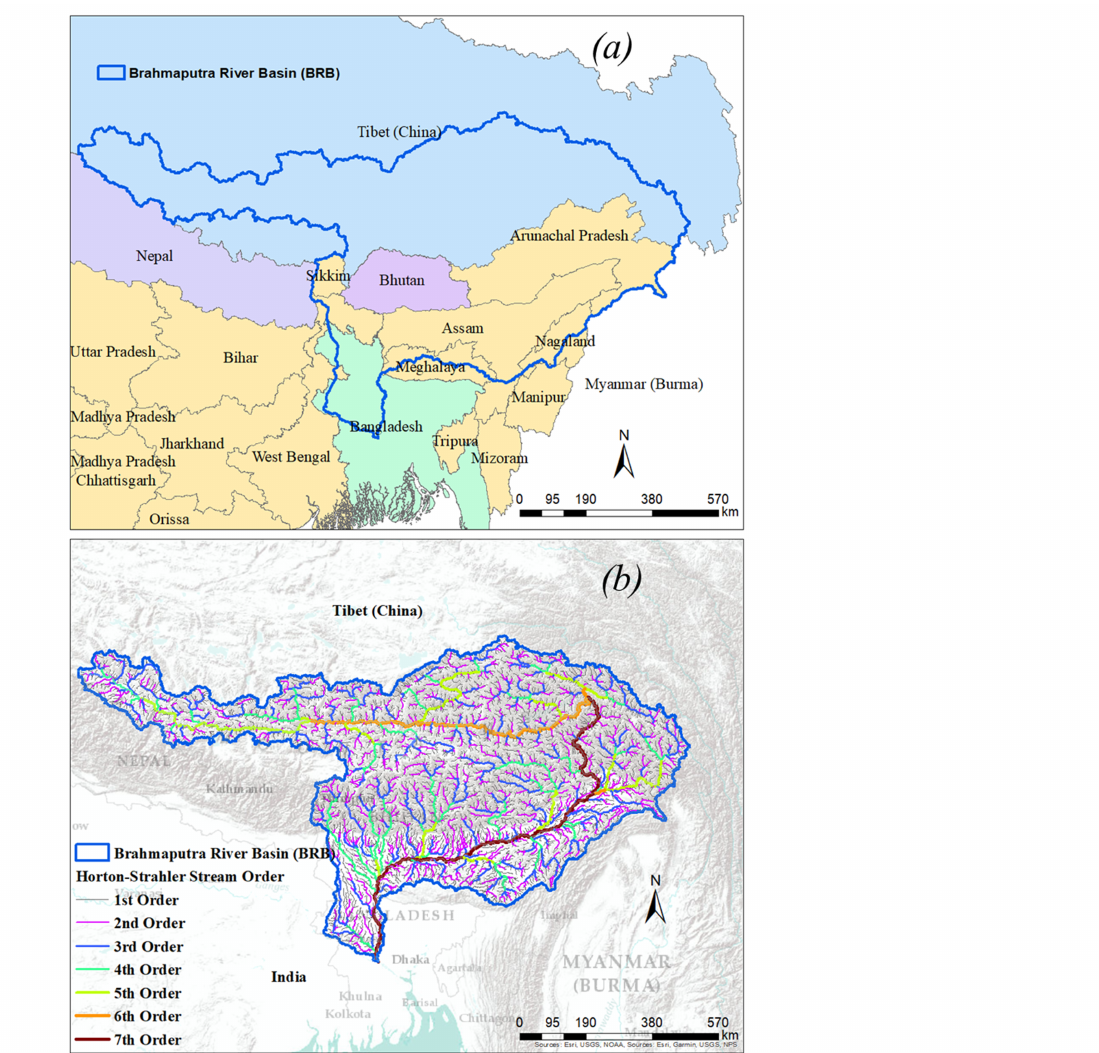
Figure 1. ( a ) The Brahmaputra River Basin (BRB) extent and ( b ) one-dimensional river network extracted from [4,6,8] for the